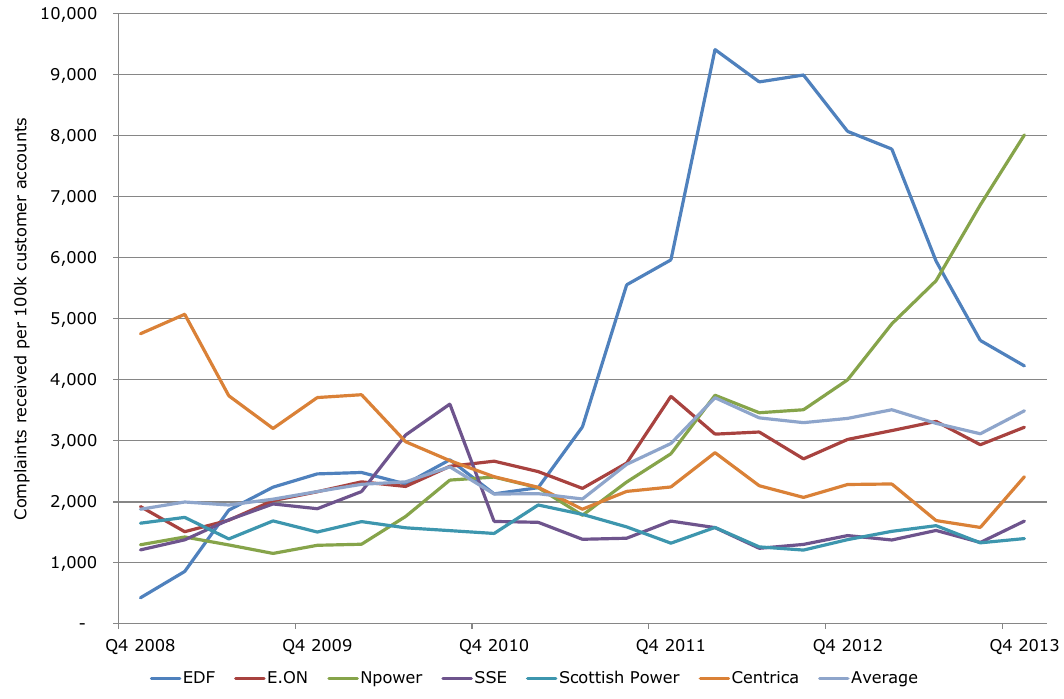
Figure 12: Complaints received per 100k customer